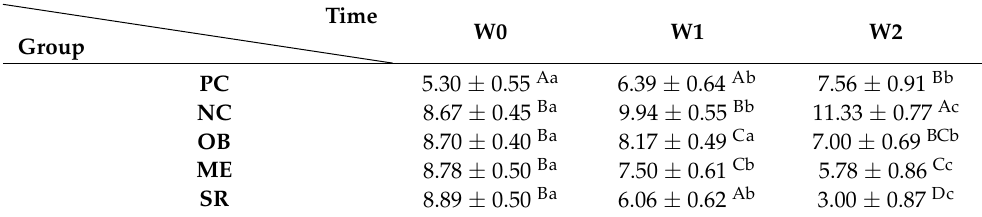
Table 1. Average number of wrinkles after each week of treatment.